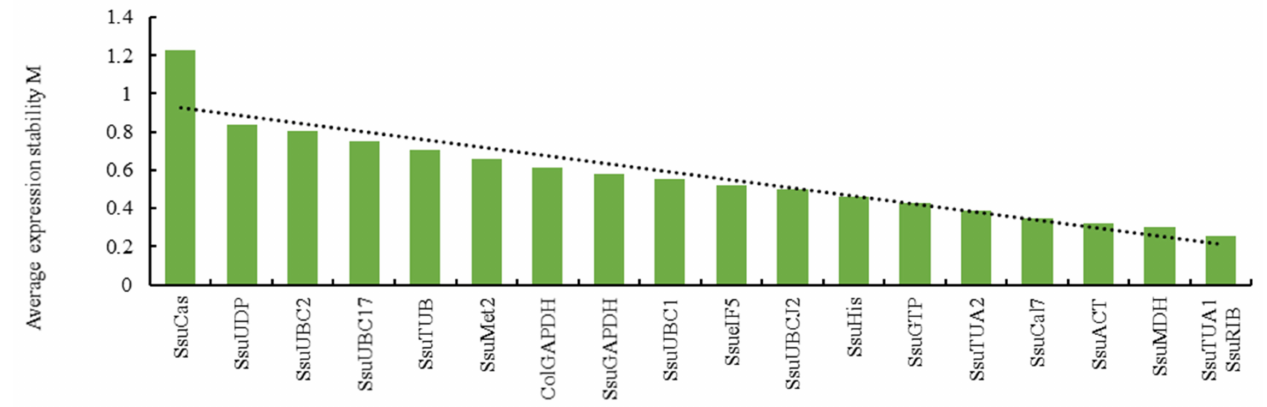
Figure 1. Expression stability values (M) of candidate reference genes calculated by geNorm. The pairwise variation value (Vn/Vn+1), calculated by geNorm, determined the optimal number of reference genes. When Vn/Vn+1 < 0.15, the optimal number of reference genes is n , otherwise, the number is n +1 [26]. In this study, except for V18/V19, the other value of Vn/Vn+1 < 0.15 (Figure 2), indicating two reference genes, would be sufficient for gene normalization, and an increase did not improve sensitivity.